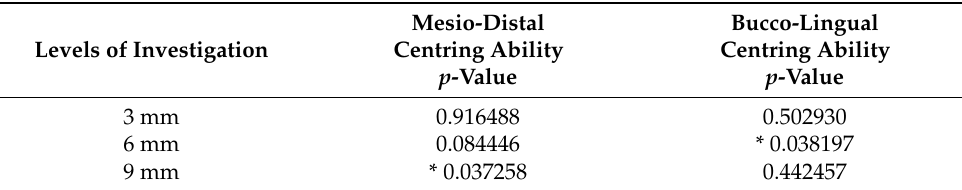
Table 2. The p -values of the ANOVA statistical analysis between the considered groups regarding the centring ability at the three investigated